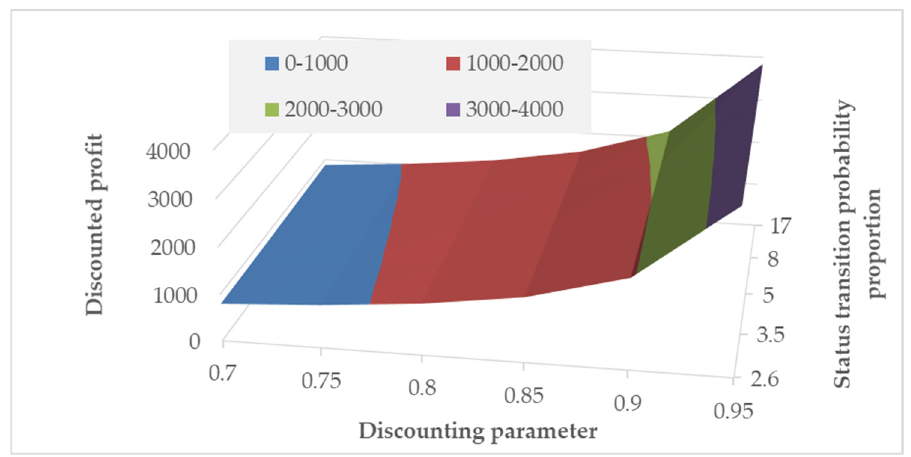
Figure 11. Impact of the initial system status and the 𝜗 discount parameter on the discounted profit resulted by the optimized maintenance policy.